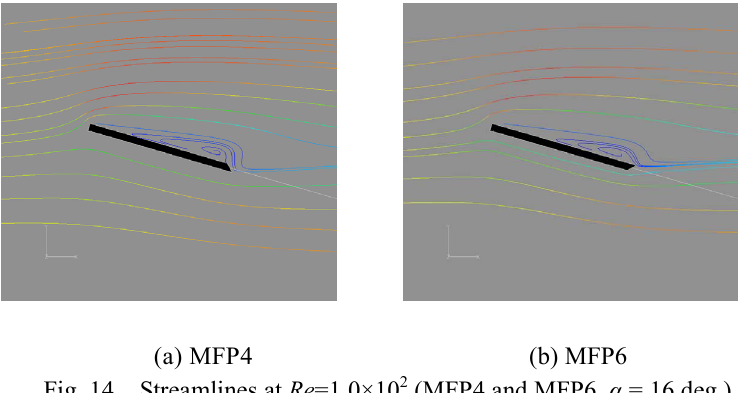
Streamlines at Re =1.0×10 2 (MFP4 and MFP6, α = 16